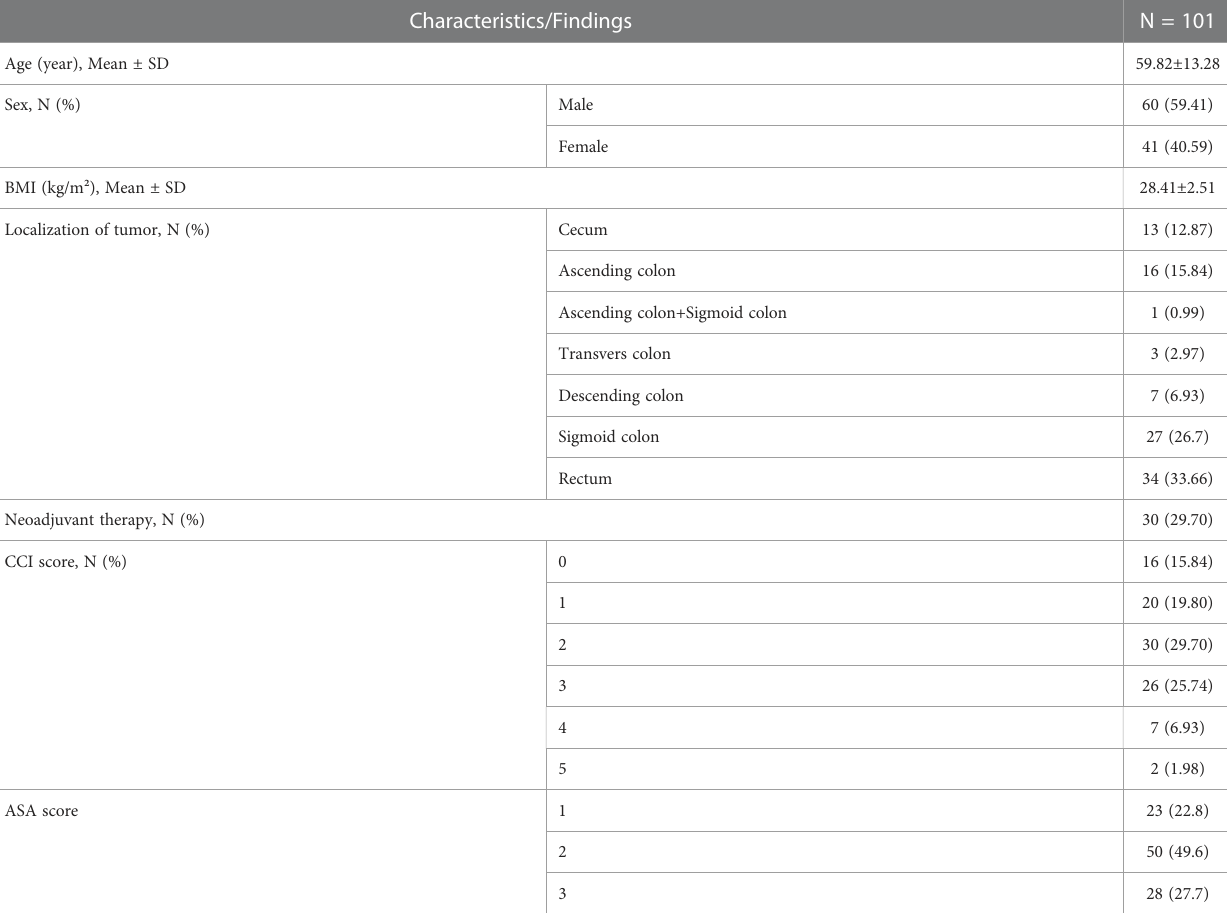
TABLE 1 Patient